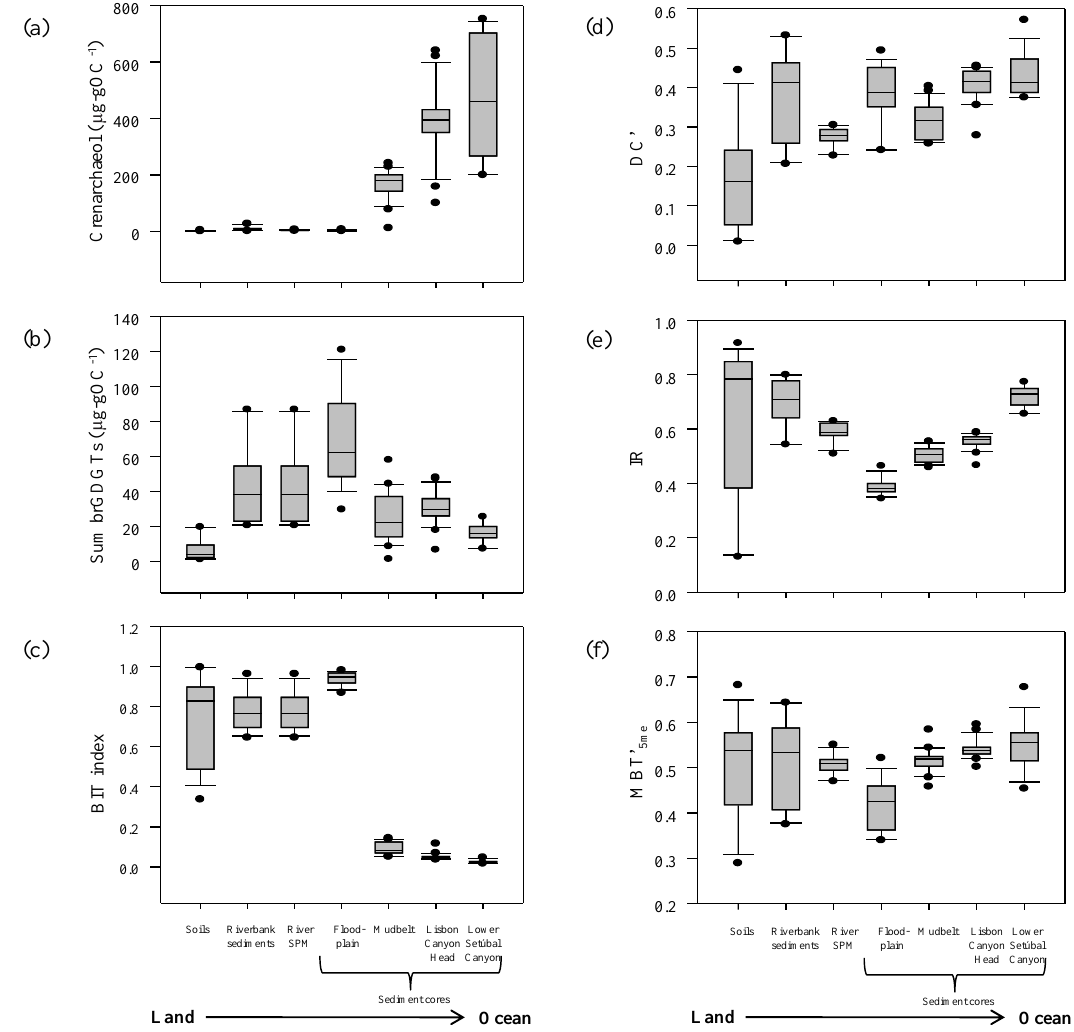
Figure 3. Box plots of (a) crenarchaeol concentrations (µggOC − 1 ) , (b) sum of brGDGTs (µggOC − 1 ) , (c) BIT index, (d) DC’, (e) IR, and (f) MBT’ 5me for each sample set in the transect from the land to the ocean off the Portuguese